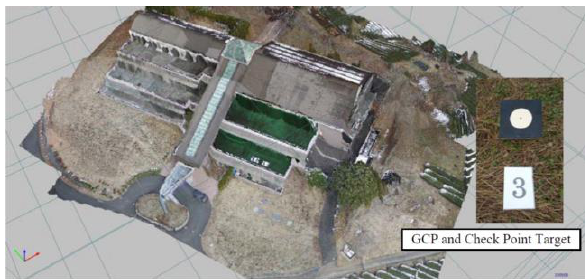
Figure 10. Example of 3D reconstruction of